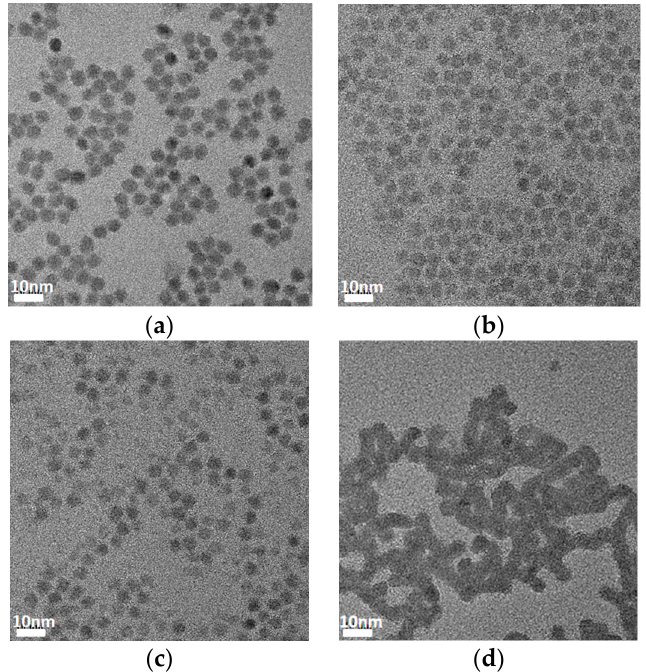
Figure 2. TEM images of the PbS QD films capped with ( a ) EDT, ( b ) TBAI, ( c ) CTAB, and ( d ) Na 2 S.